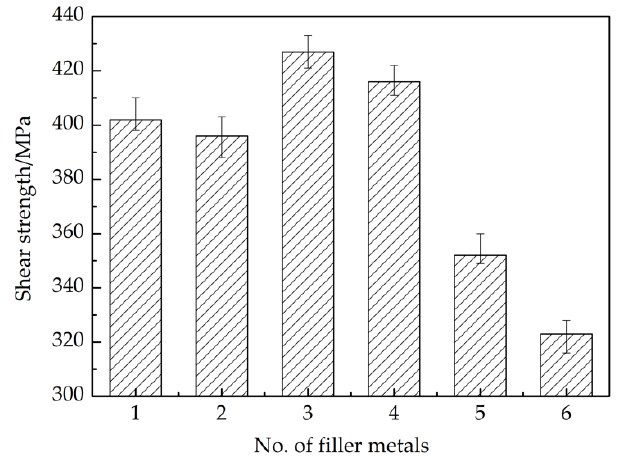
Figure 9. Shear strengths of the steel/steel lap joints using 12AgCuZnSn- x In- y Pr.